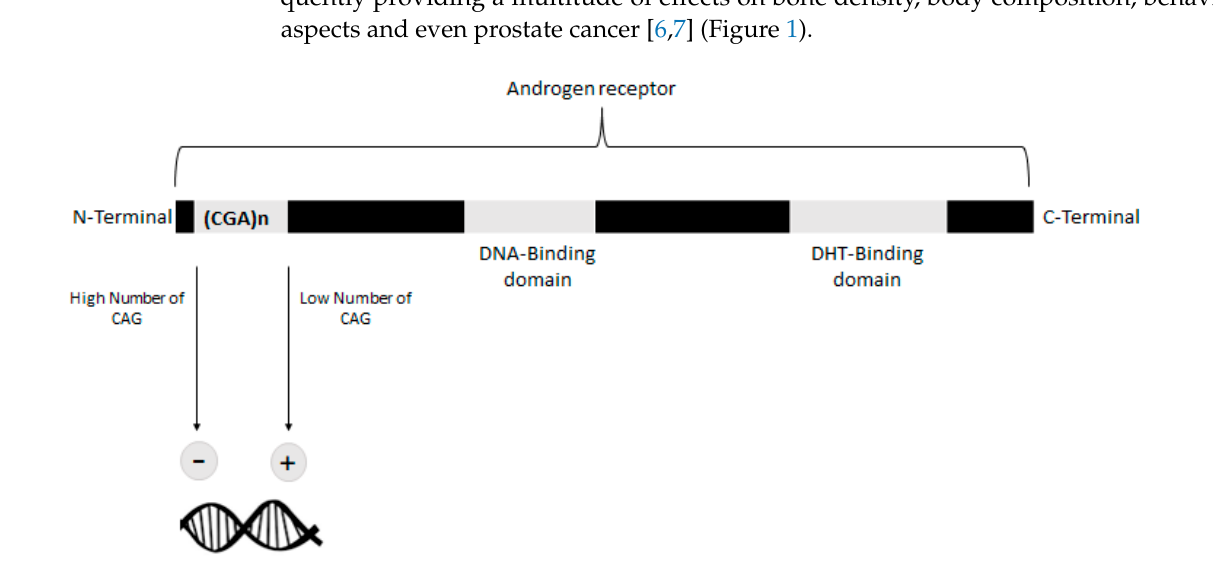
Figure 1. DNA transcriptional activity is influenced by localization of CAG. An opposite association between CAG repeat length and DNA transcriptional activity has been reported. CAG may cause structural perturbations or recruit inhibition proteins.